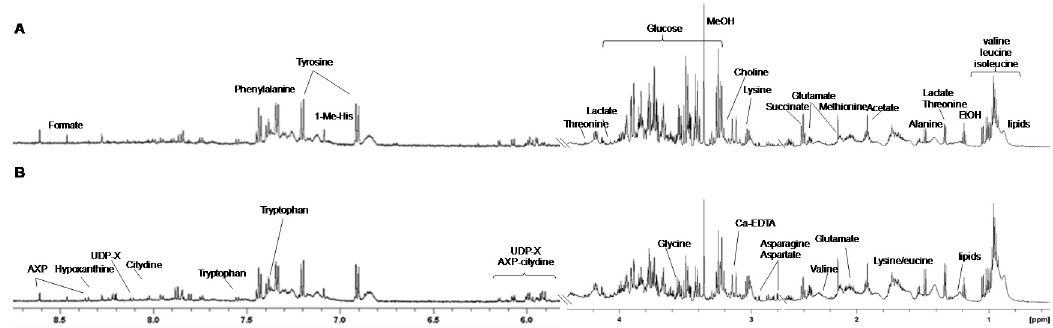
Figure 2. Representative one-dimensional 600 MHz 1 H-NMR spectra (ZGCPPR) of lysate from the treated ( A ) and control ( B ) samples in the aromatic (left) and aliphatic (right) regions with some of the identified metabolites (AXP: adenosine mono, di-, triphosphate; 1-Me-His: 1-methyl-histidine; UDP-X: uridine diphosphate-glucose).